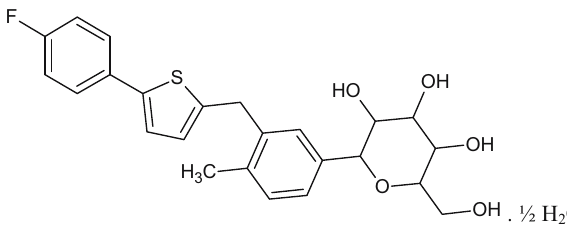
Figure 1: Structure of canagli fl ozin hemihydrate.